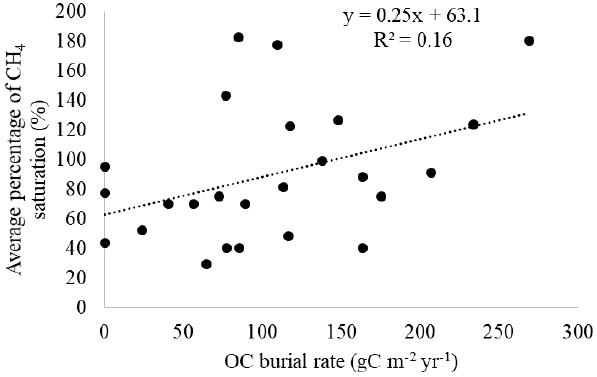
Figure 5. Regression model of average percentage of CH 4 sat- uration (%) in the sediment pore water and OC burial rate (gCm − 2 yr − 1 ). Each circle represents one sampling